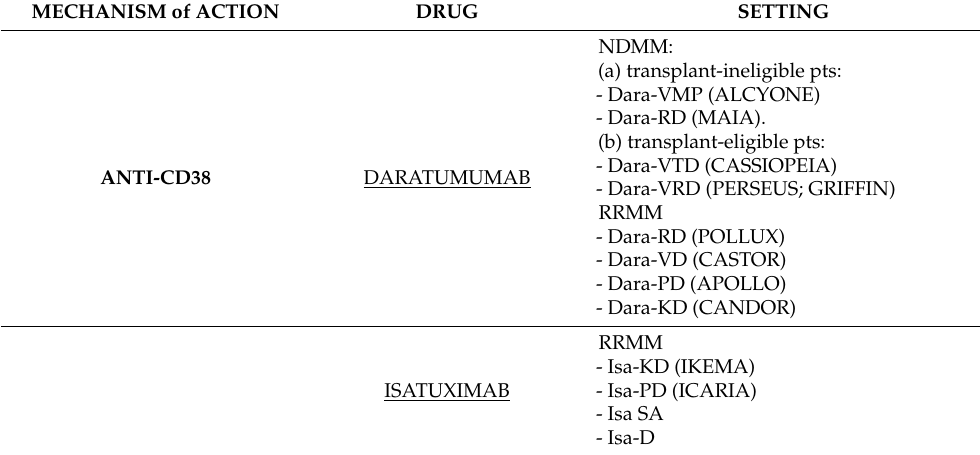
Table 1. Overview of “naked” moAbs with targets and clinical indications. NDMM: newly diagnosed multiple myeloma; RRMM: relapsed-refractory multiple myeloma; pts: patients; dara: daratumumab; isa: isatuximab; fel: felzartamab; elo: elotuzumab; SA: single agent; V: velcade; M: melphalan; P: